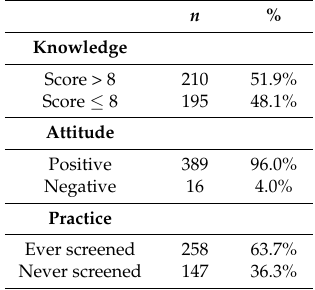
Table 4. Adequacy of knowledge, attitude towards cervical cancer and its